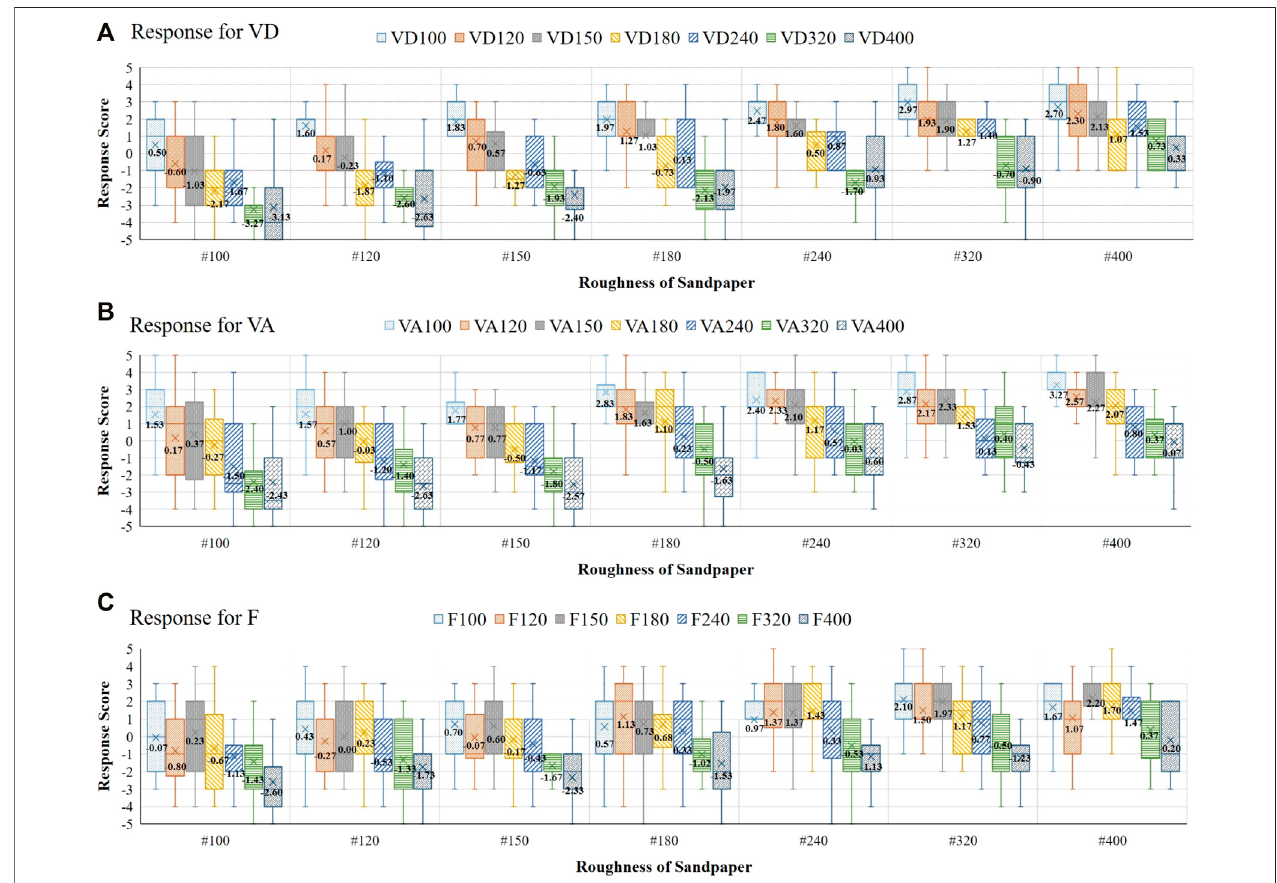
FIGURE 13 | Comparison results of three approaches. (A) Transformed acceleration; (B) directly measured acceleration; and (C) frictional force.